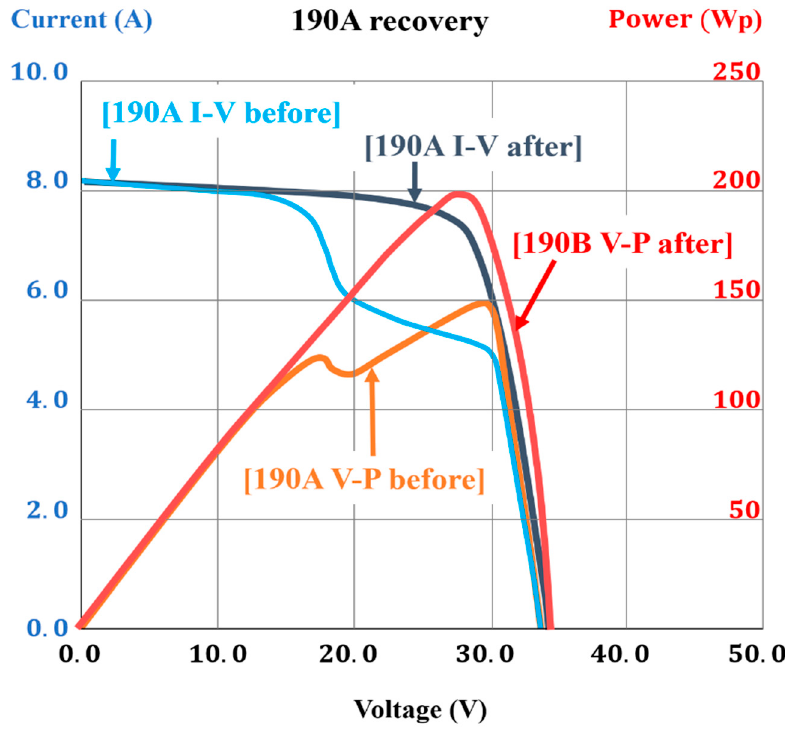
Figure 5. I–V and V–P curves before and after power recovery for sample 190 A.